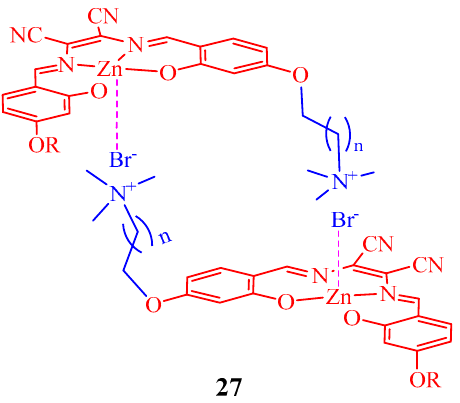
Figure 6. Proposed structure for the acentric dimeric species 27 . Reproduced from Ref. [68] with permission from The Royal Society of Chemistry.